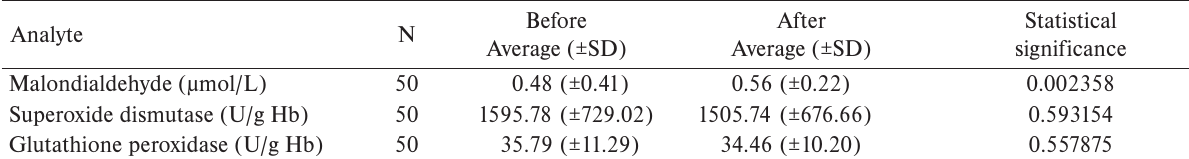
Table 4. Levels of MDA, SOD and GPx before and after RH